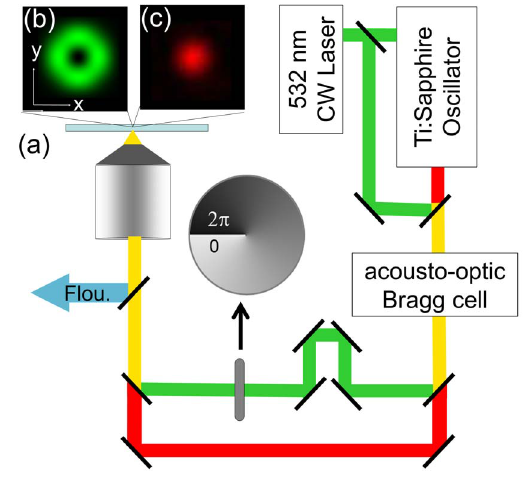
Figure 1. Experimental setup for 2PE-STED microscopy. (a) Schematic layout of modulated CW 2PE-STED microscopy. (b) The doughnut-shape intensity profile of the 532 nm depletion beam was obtained by using a spiral phase plate shown in (a). (c) The Gaussian intensity profile of the two-photon excitation beam at 860 nm.